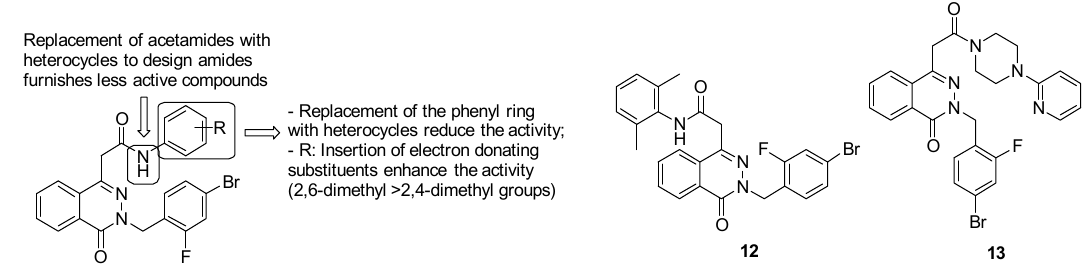
Figure 23. SARs of phthalazinyl acetamides and chemical structures of compounds 12 and 13. Among phthalazin-4-ylacetamides, compound 12 was the most active in vitro against log-phase cultures of both Mtb (MIC = 0.18 μ M) and MDR- Mtb (MIC = 0.08 μ M), showing greater MIC values than INH, RIF and ciprofloxacin. Moreover, in a starved culture of Mtb , compound 12 was more active (MIC = 3.78 μ M) than RIF (MIC = 15.2 μ M). It also showed a favorable safety profile, with toxicity in Vero cell lines only above 126.43 μ M. With respect to the enzyme target, compound 13 furnishes the highest rate of ICL inhibition (66.70%) at 10 μ M. Compound 12 was assayed in vivo against Mtb infected mice at 25 mg ⁄ kg and unfortunately showed diminished anti-TB activity in the lung and spleen (log CFU values of 6.61 and 6.12, respectively) compared to INH (log CFU values of 5.86 and 4.71, respectively).